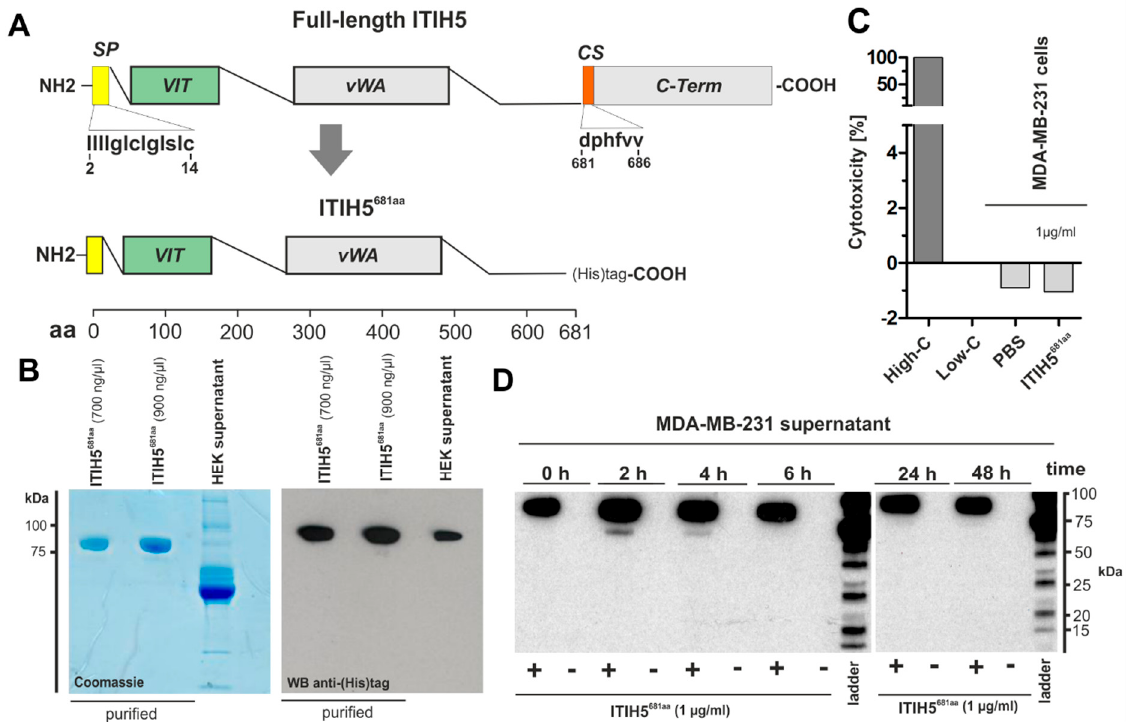
Figure 2. In vitro synthesis, toxicity, stability, and specificity of recombinant N -terminal ITIH5t polypeptides. ( A ) Schematic drawing of the full-length ITIH5 protein (942 aa) and the derived N - terminal ITIH5t protein (681 aa), which includes both the VIT (relative aa position according to specific databases: PFAM = 51–159; Prosite profiles = 35–161) and vWA (relative aa position: PFAM = 295–466; Prosite profiles = 295–478) domains. ( B ) Visualization of the recombinantly produced N - terminal ITIH5t polypeptide after purification by using Coomassie staining and Western blotting.